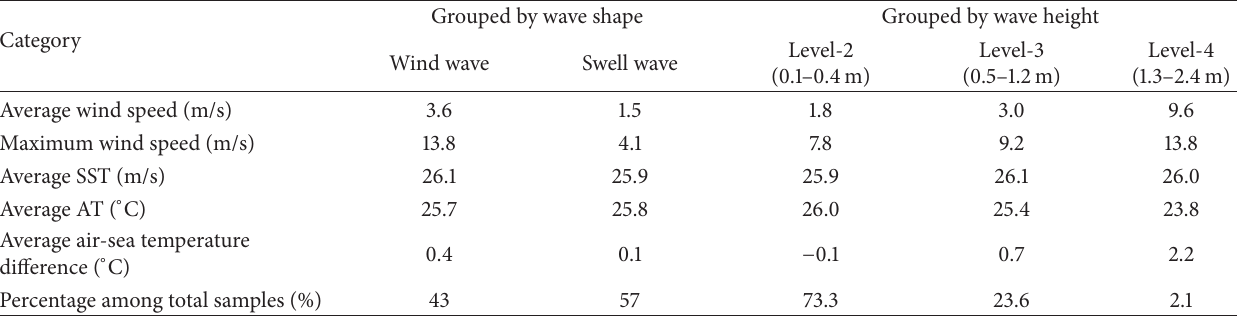
Table 2: Wave-coherent features of wind, air temperature, and